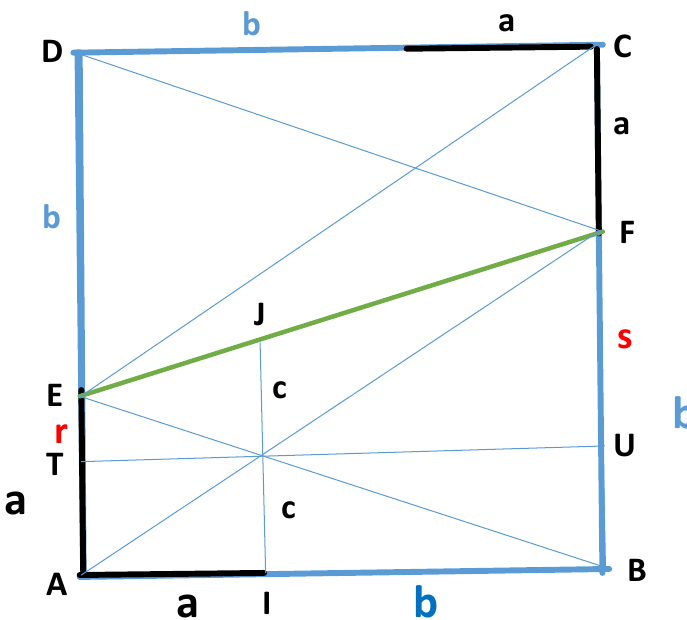
Figure 2. The symmetric crossed ladders diagram. Figure 2: The symmetric crossed ladders diagram.